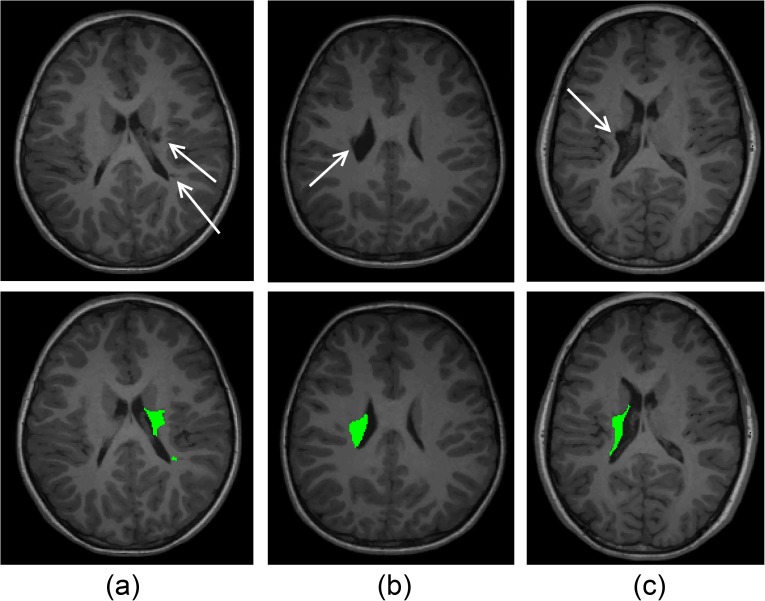
Illustration of three cases of localised enlarged ventricles due to injury, and the segmentation of the enlarged volumes from the nearest healthy ventricle shape.